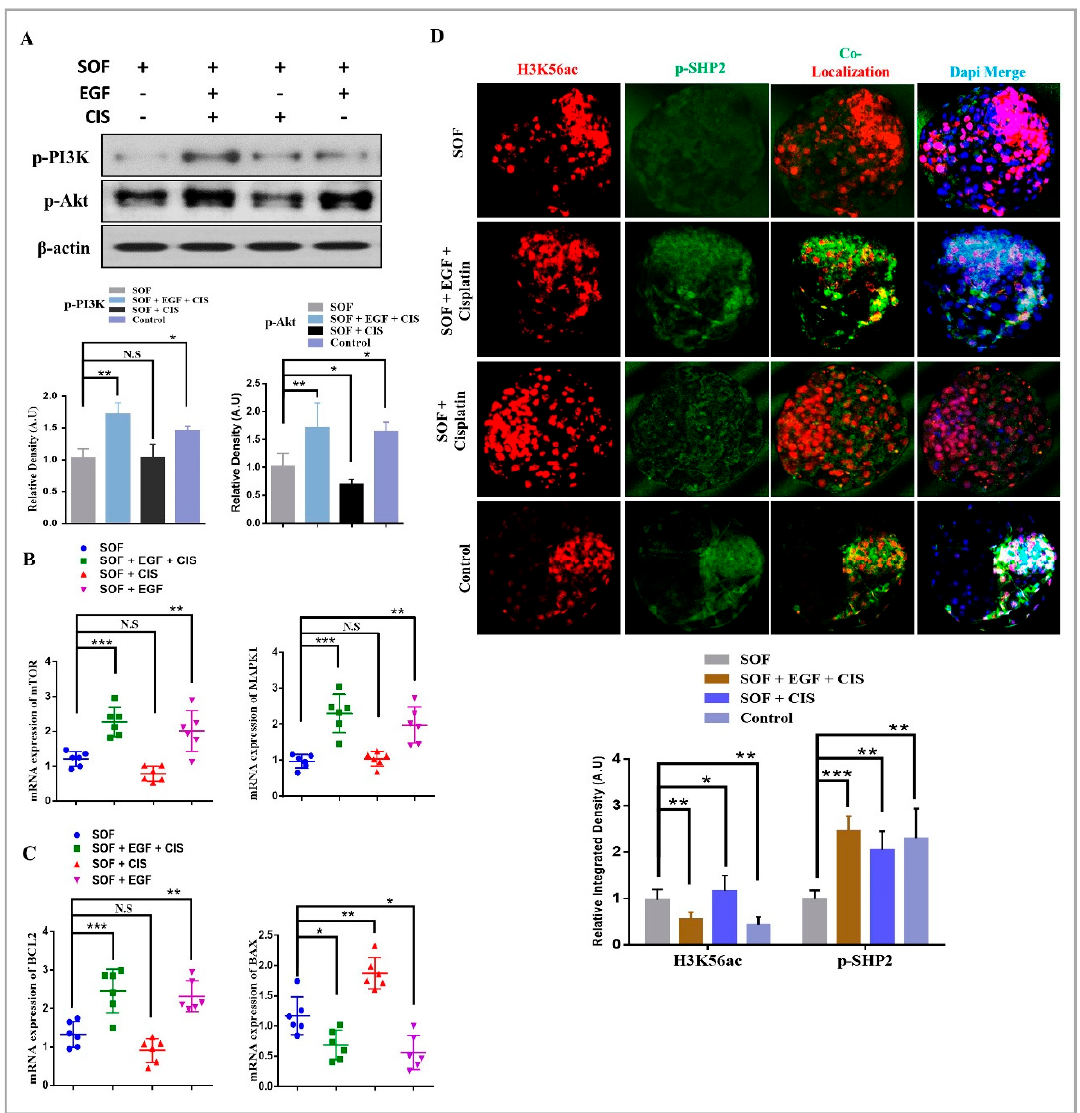
Figure 4. Consistent SHP2 expression enhance RTKs downstream signaling and chromatin stability. ( A ) Western blot of PI3K and p-AKT protein expression level was significantly enhanced in the presence of EGF in both COMBO and CONTROL groups. β -actin was used as a loading control for western blot. The bands were quantified using ImageJ software, and the di ff erences are represented by histograms. ( B ) Relative mRNA expressions of mTOR and MAPK1 in blastocysts (n = 5 per each group). ( C ) Relative mRNA expressions of BAX and BCL2 in blastocysts (n = 5 per each group). ( D ) Immunofluorescent co-localization of H3K56ac with SHP2 in bovine blastocysts (n = 20 per each group). The experiments were repeated 3 times and the data are shown here as a mean ± S.E.M. N.S, not significant. * P < 0.05, ** P < 0.01, *** P < 0.001.